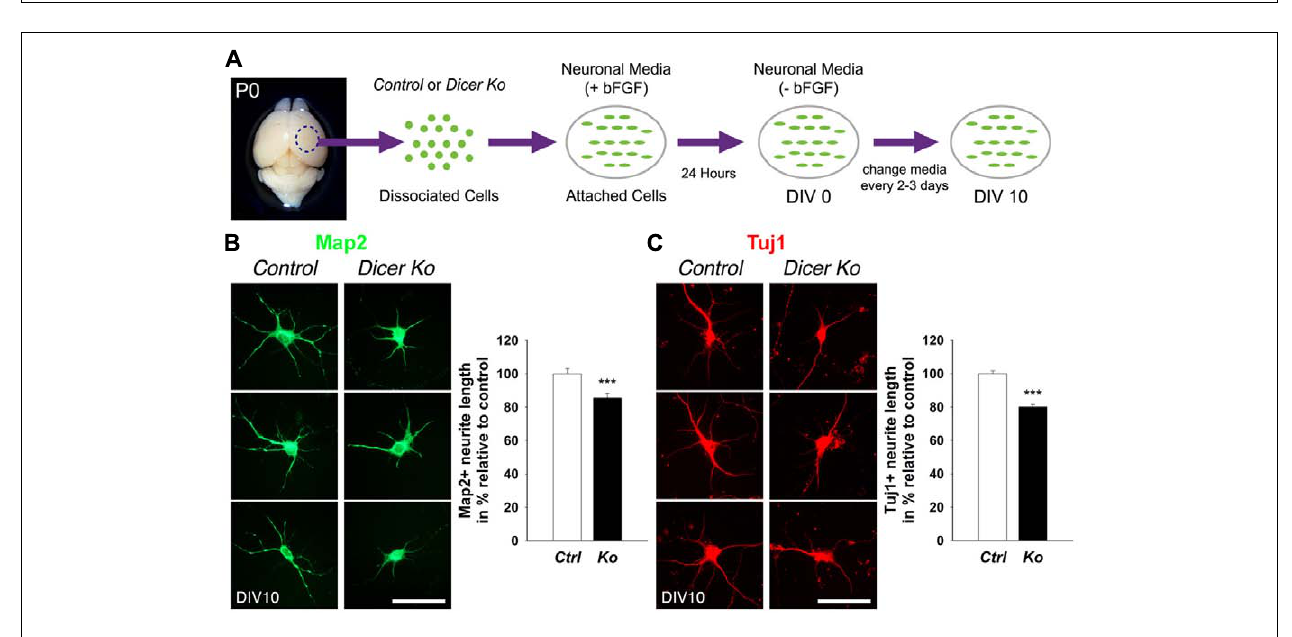
FIGURE 5 | Loss of Dicer in mature neurons delays neurite outgrowth in vitro . (A) An illustrative summary of primary neuronal culture derived from control ( Ctrl ) and Nex-Cre-Dicer Ko ( Ko ) P0 dorsal cortex. (B) Measurements of Map2 + processes revealed shorter neurite outgrowth 10 days in vitro (DIV 10) in Dicer Ko ( N = 113) neural cultures